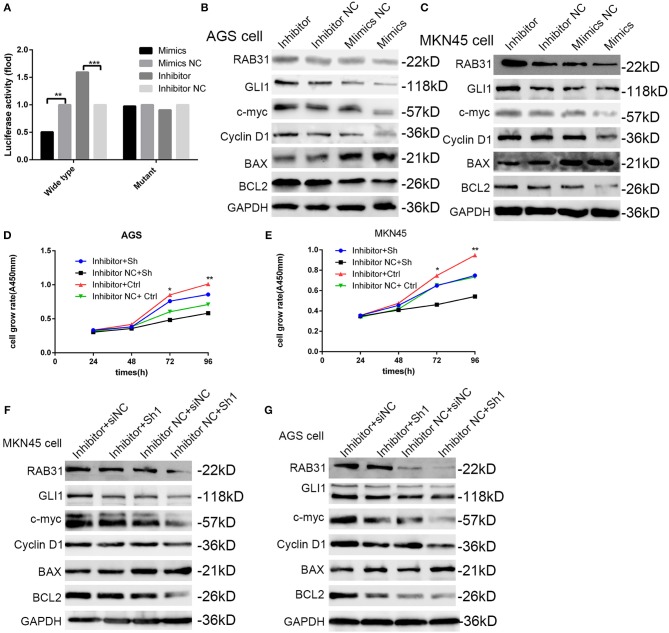
miR-30c-2-3p is involved in the RAB31/GLI1 pathway and regulates GC cell growth and apoptosis via binding to the 3′-UTR of RAB31. (A) Luciferase reporter assay was performed using MKN45 cells to determine if miR-30c-2-3p binds to the 3′-UTR of RAB31. (B,C) RAB31, GLI1, cyclin D1, BAX, and Bcl-2 expression was detected by Western blotting in AGS and MKN45 cells after transfection with miR-30c-2-3p mimics or the inhibitor; GAPDH was used as the control. (D,E) Cell viability was assessed in AGS and MKN45 cells transfected with the miR-30c-2-3p inhibitor and RAB31 siRNA. (F,G) Western blotting was conducted to investigate the levels of RAB31, GLI1, and its downstream proteins in AGS and MKN45 cells co-transfected with the miR-30c-2-3p inhibitor.